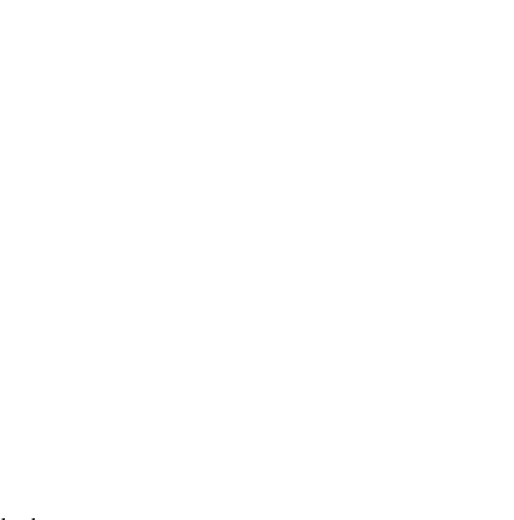
Table 8. Effect of (anti-) motifs on product structural